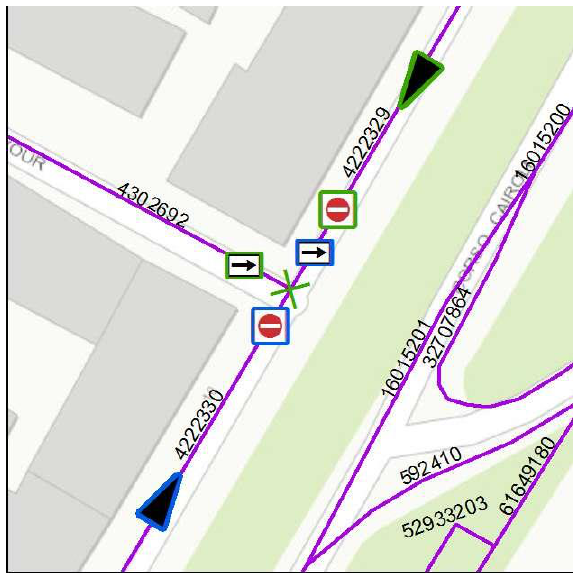
Figure 8. Enhanced traffic sign positioning and network restriction update based on option 1 (green outline) or option 2 (blue